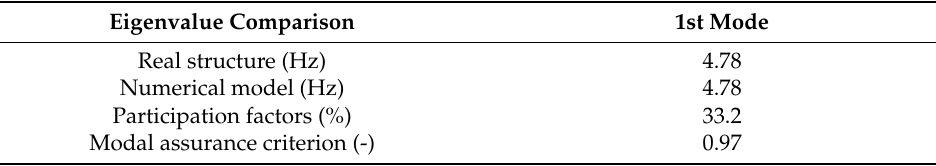
Figure 10. Mode shapes identified by eigenvalue analysis: ( a ) fundamental mode shape of the Otaru warehouse, fundamental mode shapes of the Matsumoto storehouse in the x- direction ( b ) and in the y- direction ( c ). Table 3. Eigenvalue comparison of the Otaru